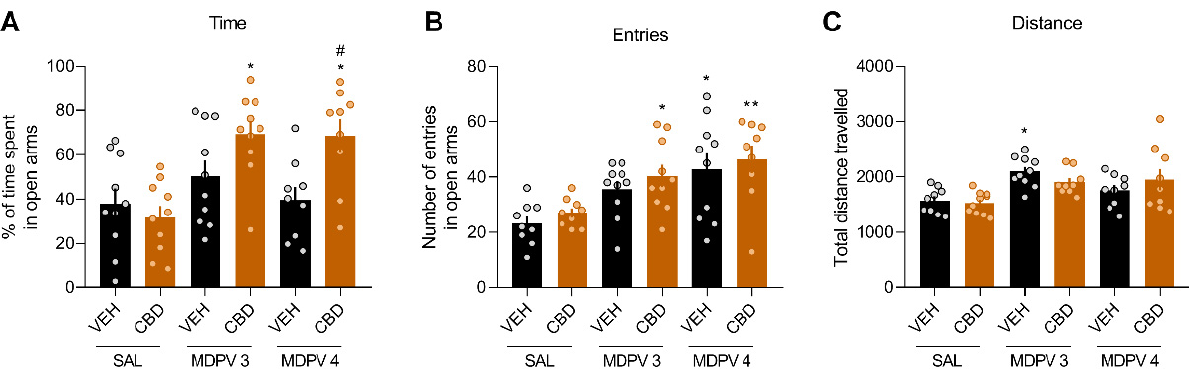
Figure 5. CBD exerts anxiolytic effects in the EPM only when co-administered with MDPV. ( A ) Percentage of time spent in open arms ( n = 9–10/group). Bonferroni, * p < 0.05 vs VEH-SAL, # p < 0.05 vs VEH-MDPV 4 mg/kg. ( B ) Number of entries in open arms. Bonferroni, * p < 0.05 vs VEH-SAL, ** p < 0.01 vs VEH-SAL. ( C ) Total distance travelled. Bonferroni, * p < 0.05 vs VEH-SAL.